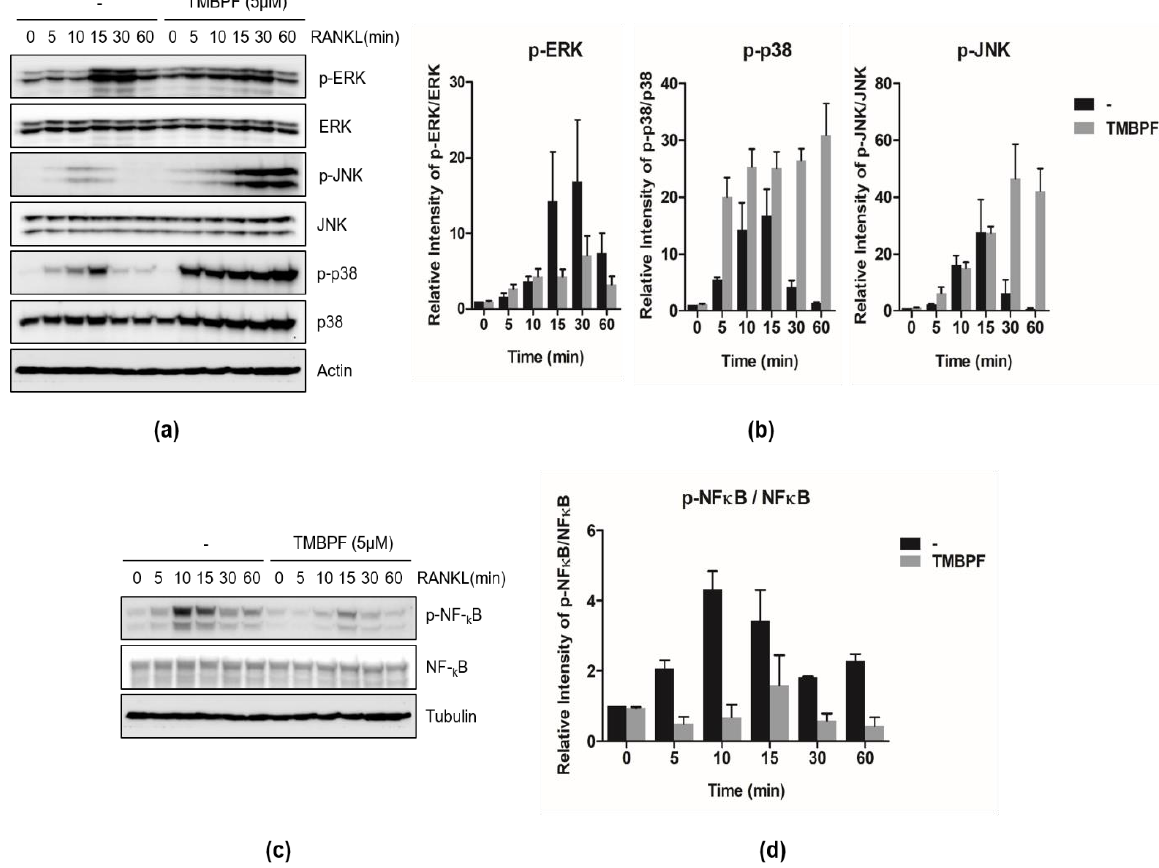
Figure 5. Effect of TMBPF on MAKP kinase and the NF-kB signaling pathway. RAW 264.7 cells were incubated with RANKL (50 ng/mL) and in presence or absence of TMBPF (5 μM) for indicated times (0, 5, 10, 15, 30, 60 min). ( a , c ) Phosphorylation of ERK, JNK, p38, and NF-kB was determined by western blotting. The measurement of intensity p-ERK, p-JNK, p-p38, and p-NF-kB were normalized by ( b ) β -actin and ( d ) α -tubulin.